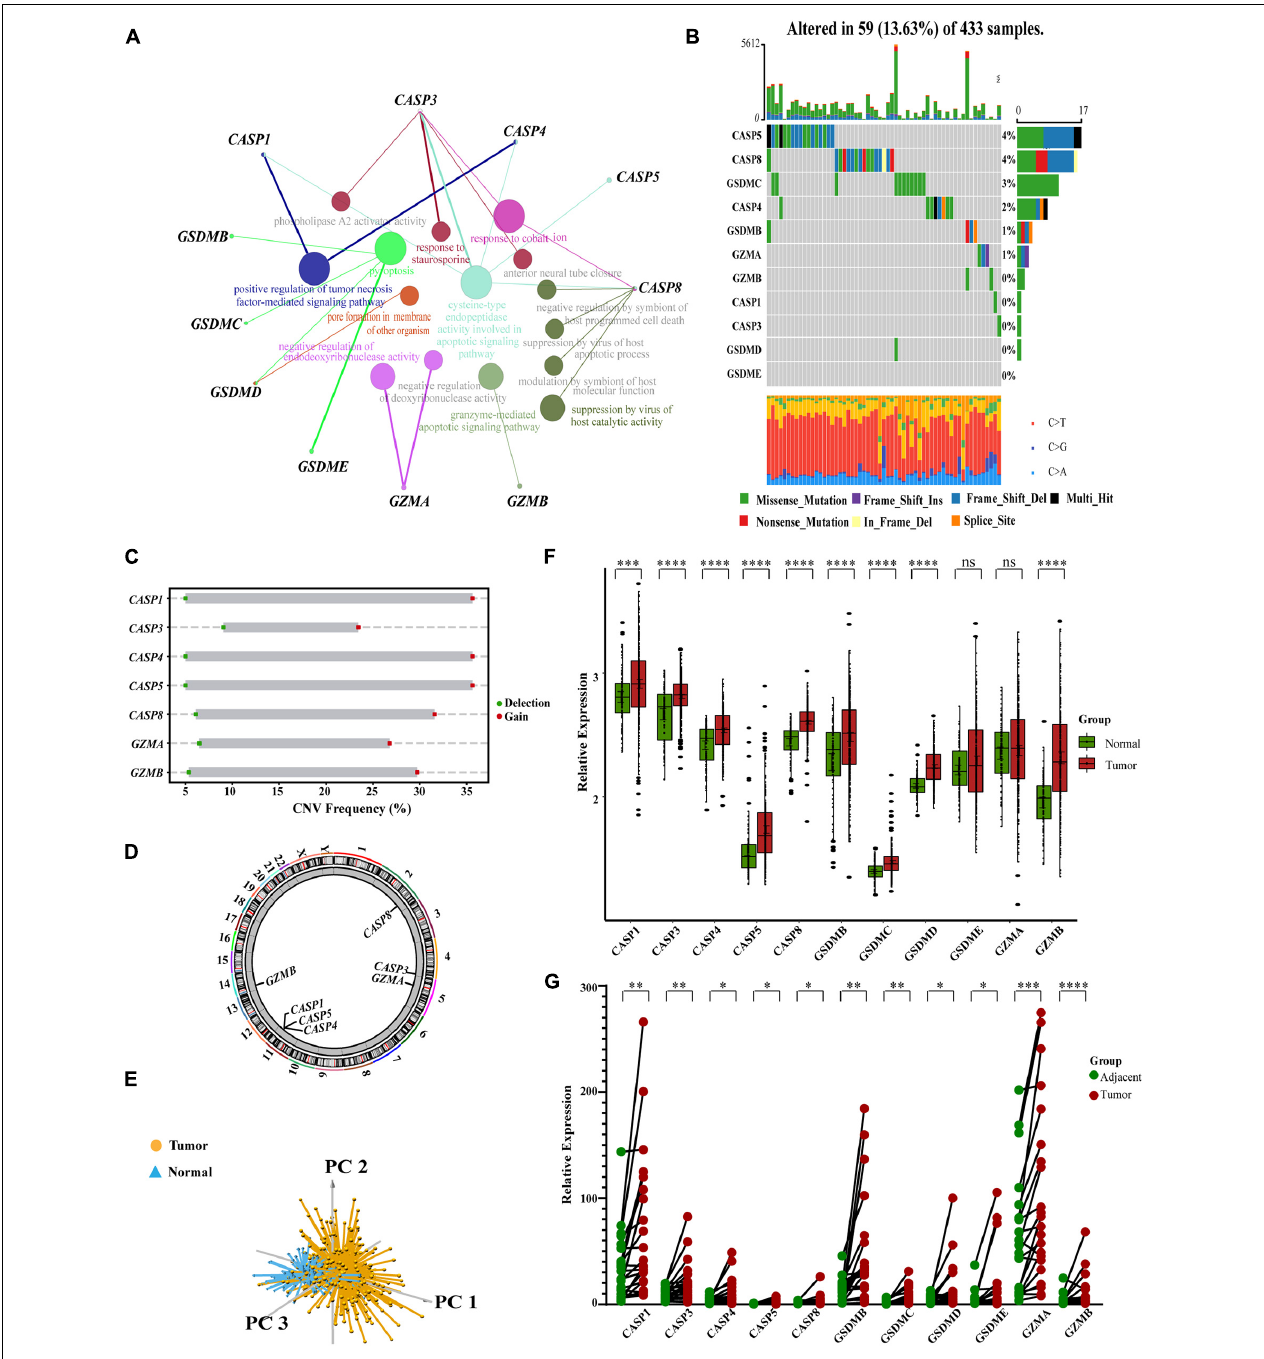
FIGURE 1 | Characteristics and differences of pyroptosis-related regulators in GC. (A) An aggregate of the potential biological interaction of pyroptosis-related regulators from STRING platform. (B) The landscape of mutation profiles in 433 gastric cancer patients from TCGA-STAD cohort. Every waterfall plot represented mutation information of each pyroptosis-related regulator. Corresponding colors had annotations at the bottom which mean different mutation types. The above barplot showed mutation burden. The right numbers represented mutation frequency individually. (C) CNV frequency of pyroptosis-related regulators in GSE62717 cohort. The height of the columns showed proportions of different types. CNV, copy number variations. (D) The location of CNV alteration of pyroptosis-related regulators on chromosomes by GSE62717 cohort. CNV, copy number variations. (E) Principal component analysis for the expression of pyroptosis-related regulators to distinguish tumors ( n = 300) from normal samples ( n = 100) in GSE66229 cohort. (F) The expressions of pyroptosis-related regulators between normal tissues ( n = 100) and gastric tissues ( n = 300) in GSE66229 cohort (Wilcox test, ∗ P < 0.05; ∗∗ P < 0.01; ∗∗∗ P < 0.001; ∗∗∗∗ P < 0.0001; ns, not statistically significant). (G) The mRNA levels of pyroptosis-related regulators in twenty-two pairs of GC and their paired adjacent normal tissues ( n = 22) were measured by real-time PCR (Paired t -test, ∗ P < 0.05; ∗∗ P < 0.01; ∗∗∗ P < 0.001; ∗∗∗∗ P < 0.0001).